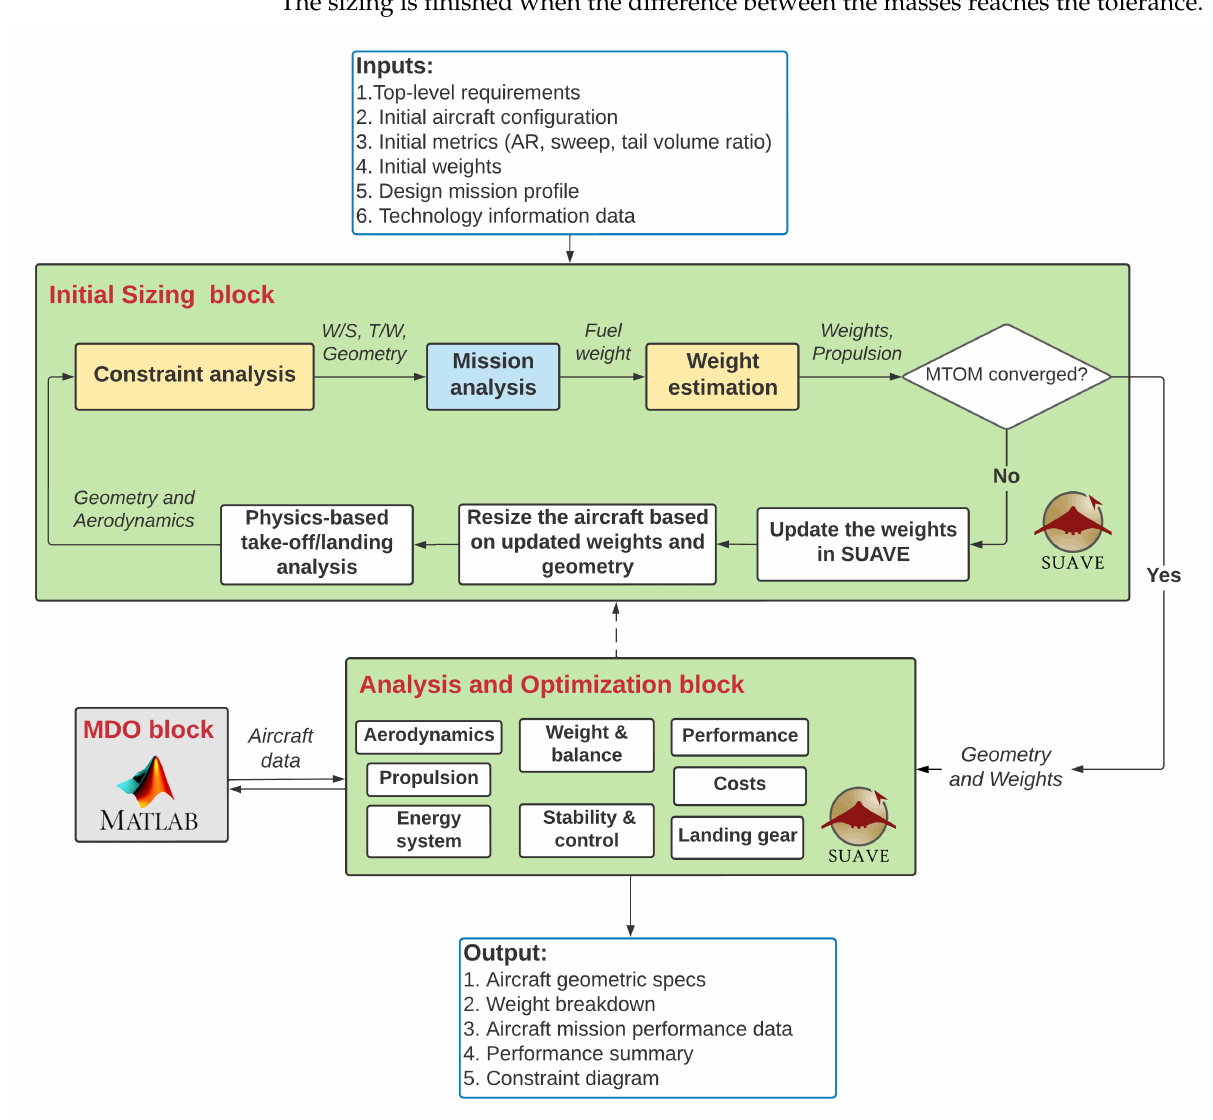
Figure 2. Initial aircraft sizing framework using